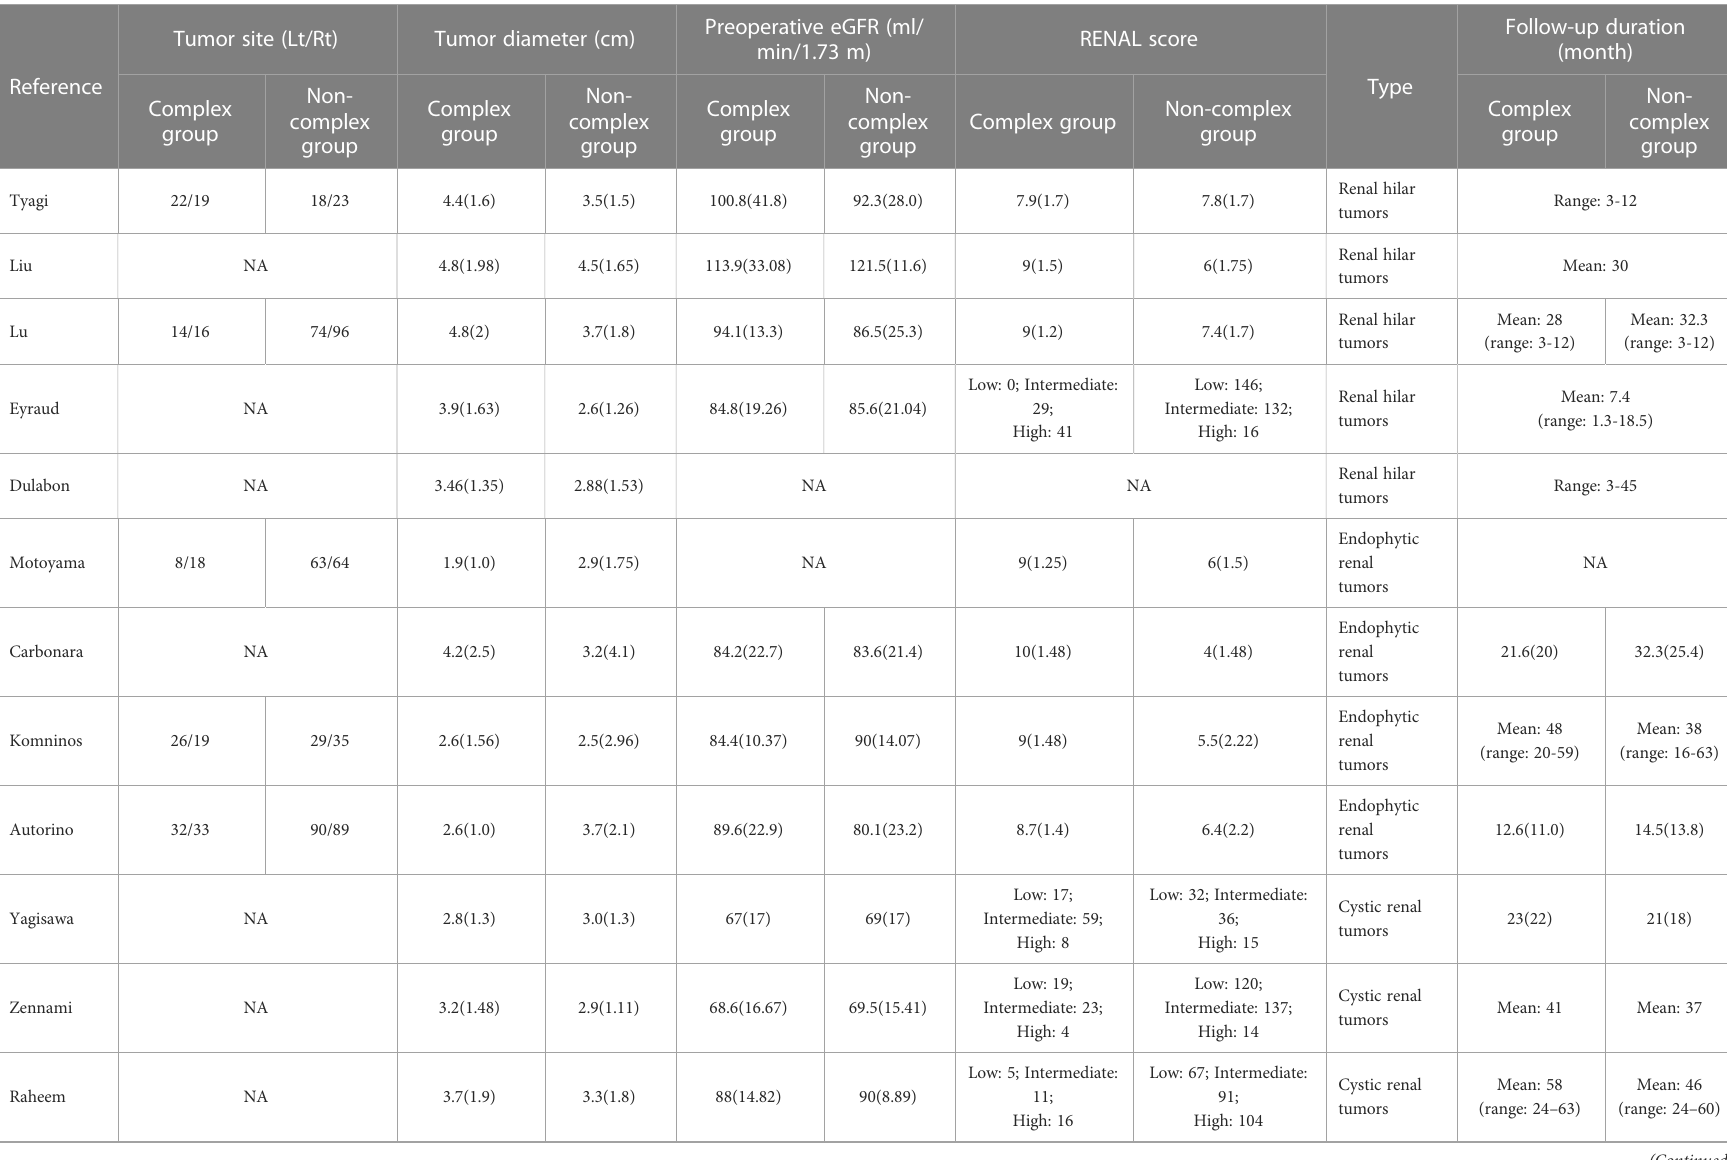
TABLE 2 The trials included in the systemic